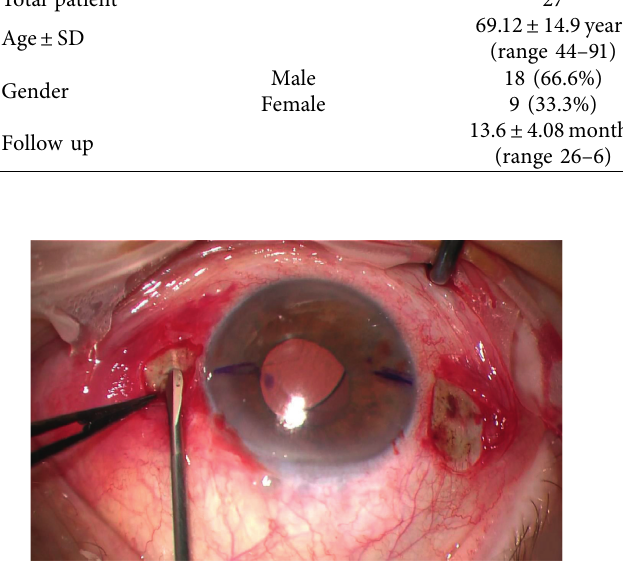
Figure 2: Creation of scleral pockets bilateral of the scleral tunnel.